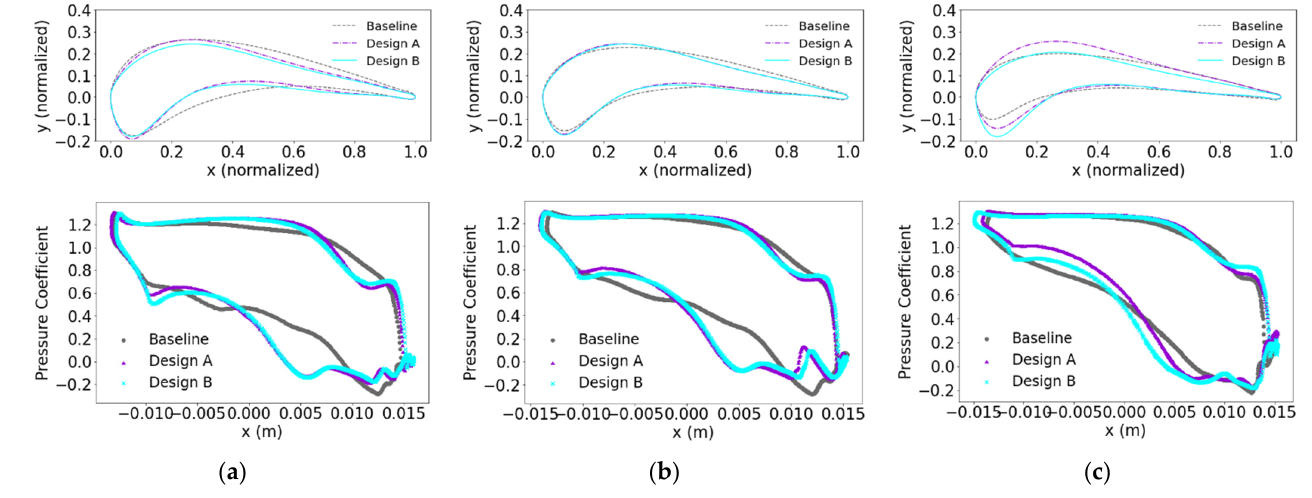
Figure 14. Blade profiles (first row) and pressure coefficients in the streamwise direction (second row): ( a ) hub sections comparison; ( b ) mid sections comparison; and ( c ) tip sections comparison. To further investigate the differences in solutions, a volume rendering scene is created by focusing on visualizing changes in Mach number within the range between 0.8 and 1.2, shown in Figure 15. The goal of this plot is to reveal where sudden changes in Mach number may occur in the transonic flow regime. A consistent shock structure near the trailing edge covering the full span length of the blade is observed in the baseline design, which is consistent with the high pressure spot in the same area highlighted by the dotted circle in Figure 11a. This shock feature is missing in the two optimized designs (Designs A and B), due to the weaker gradients in those designs.